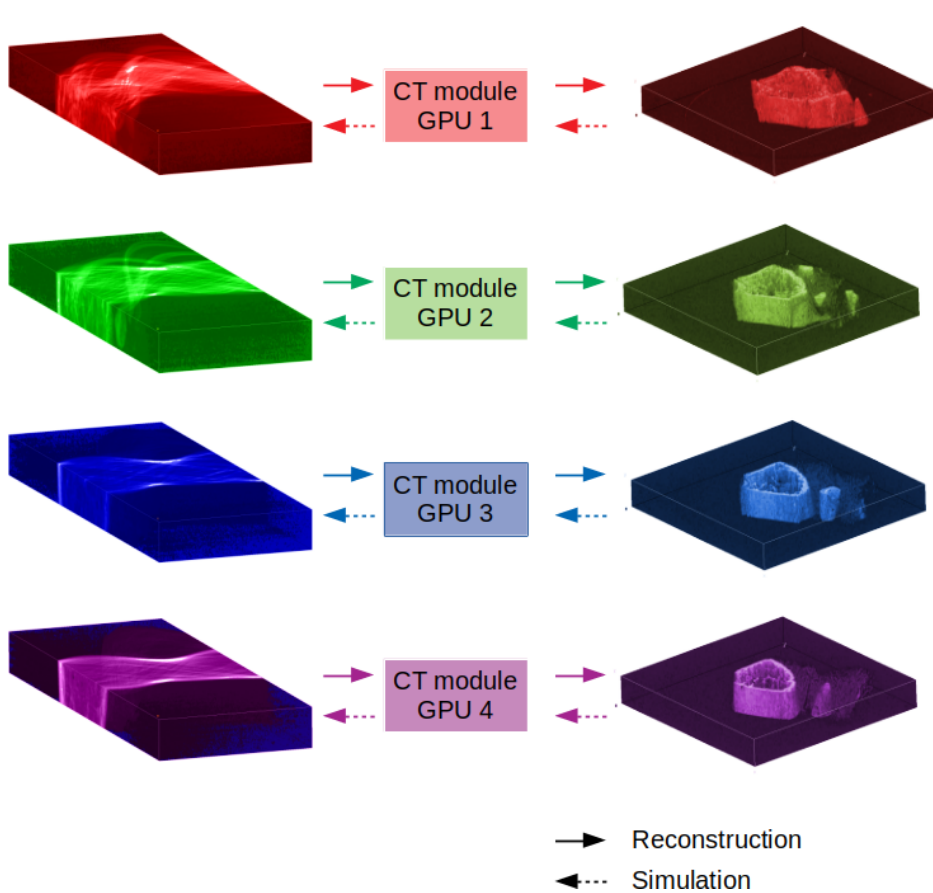
Figure 3. The tomography module: a large dataset is automatically sliced among n = 4 GPUs. Both reconstruction and projections are